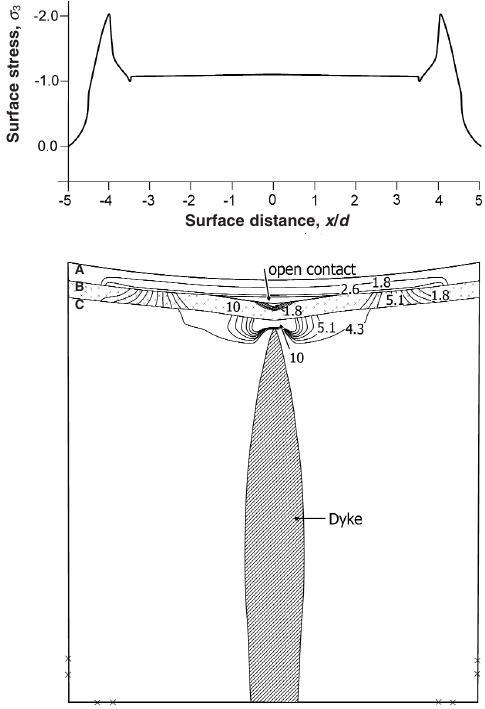
Fig. 20. Boundary-element model of a dyke with a tip at 1 km depth below the surface of a rift zone or a volcanic edifice ( cf. Gudmundsson, 2003). The up- per contact between layers A and B , at 0.4 km depth, is weak and modelled as an internal spring with a stiffness of 6 MPa/m. This contact opens up when the dyke tip approaches. The contours show the val- ues between 1 and 10 MPa of the maximum princi- pal tensile stress σ 3 . The upper diagram shows that there is little dyke-induced tensile stress at the sur- face above the dyke. However, there are higher ten- sile stresses at the margins but these occur above the lateral ends (at roughly 4 km to either side of the dyke) of the weak contact at 0.4 km depth. The low- er diagram shows the tensile stress concentration at the dyke tip, the maximum value being σ 3 = 174 MPa ( cf. eqs. (5.1), (5.2) and